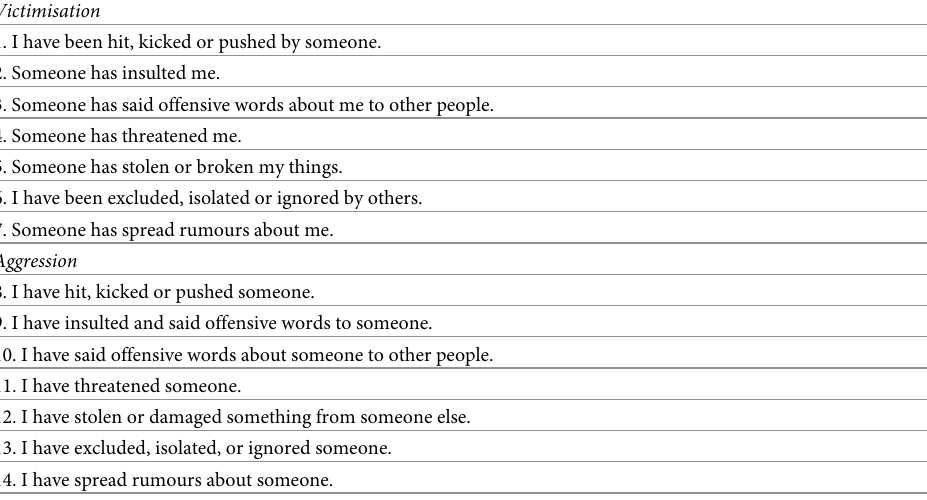
Table 1. The questions related to bullying behaviours were the following (EBIPQ Ortega-Ruiz et al. [18].